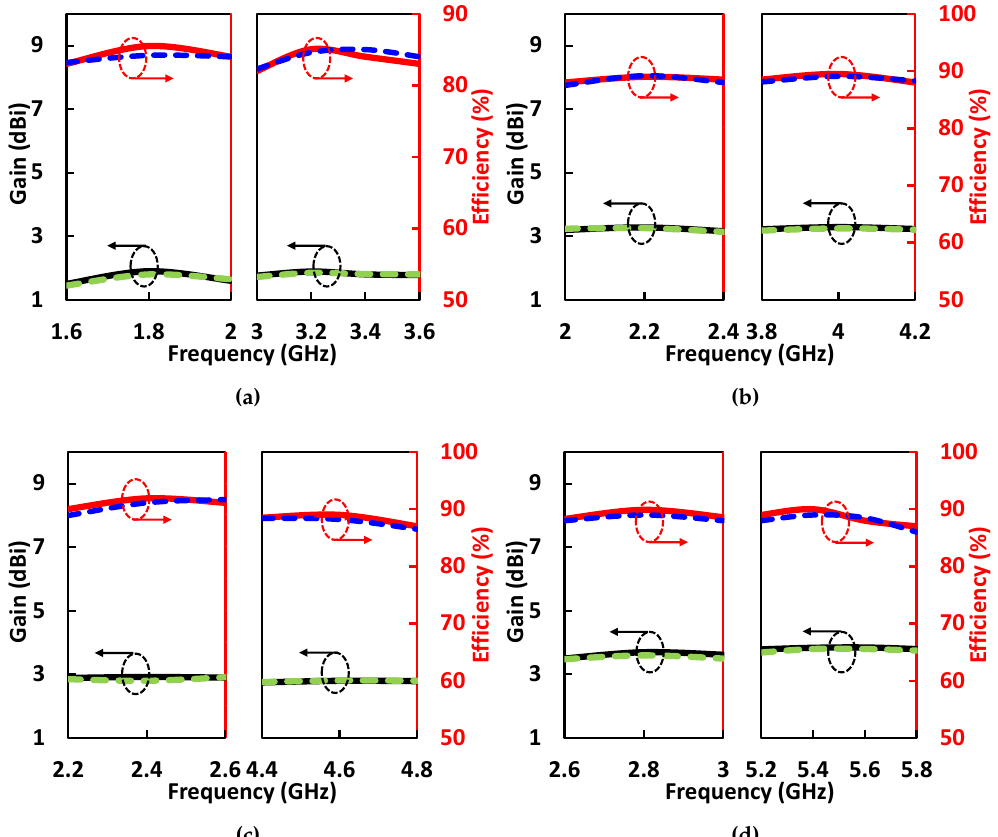
Figure 5. Gain and efficiency of the antenna (solid line = simulated, and dashed line = measured): ( a ) Mode 1; ( b ) Mode 2; ( c ) Mode 3; and ( d ) Mode 4.